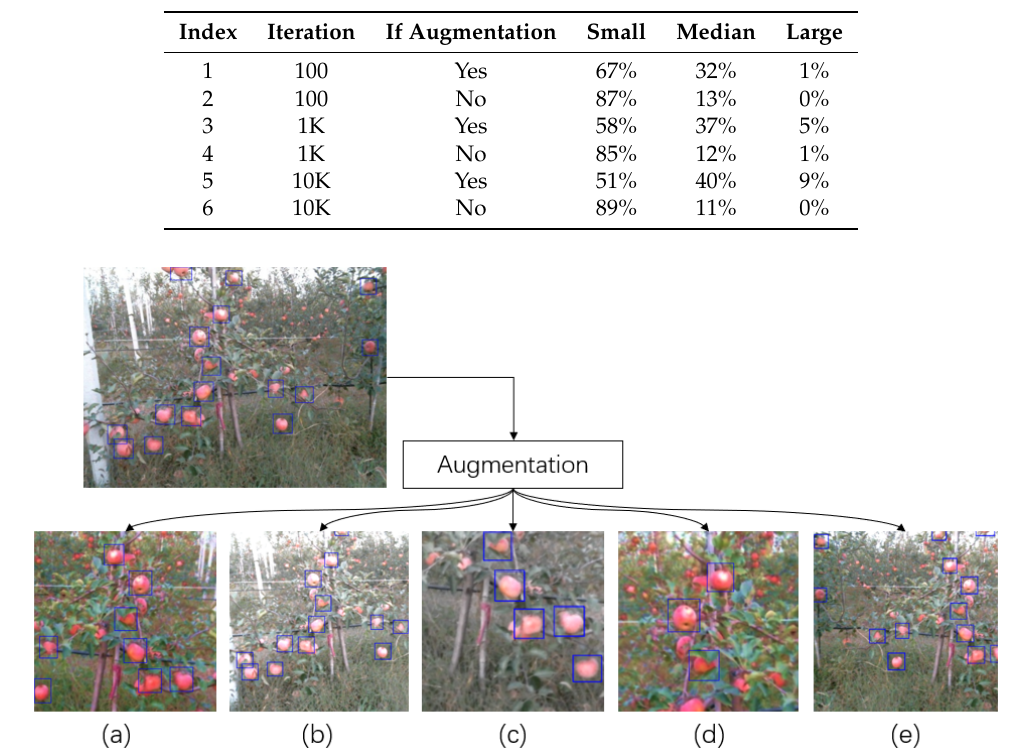
Table 1. Statistic of different scale of object in the training data during the network training.